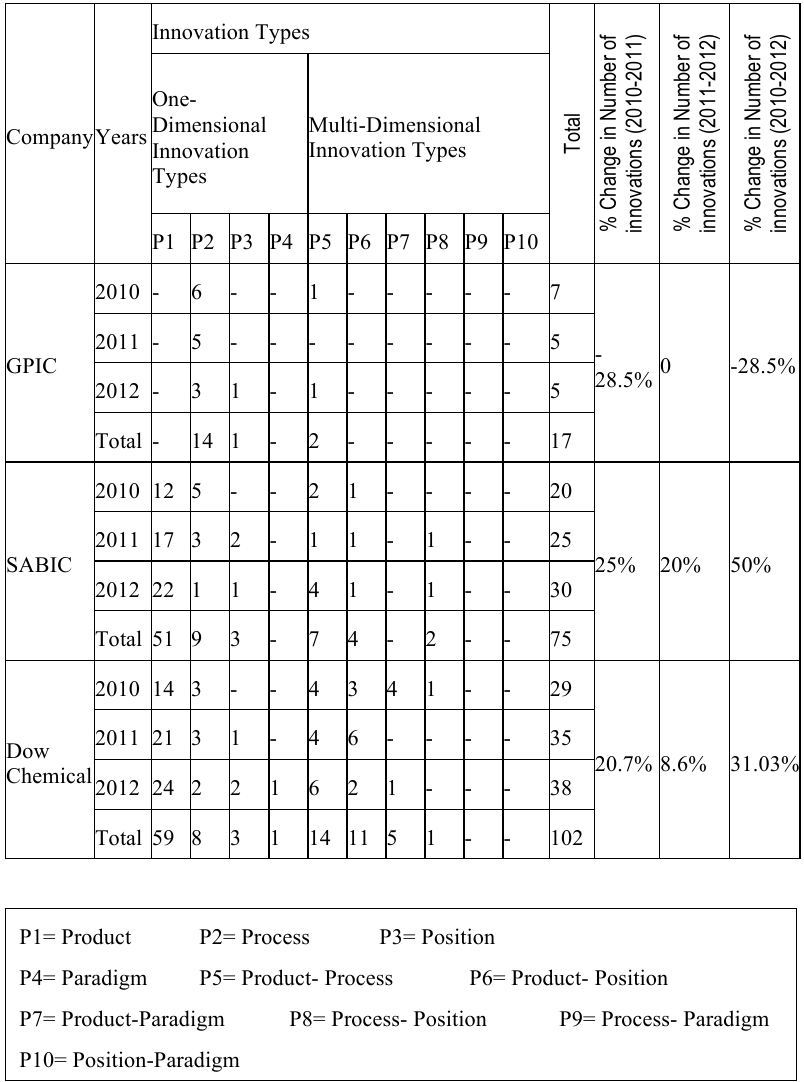
Table 1. Innovation number, Types, and Percentage of change in innovations number for the three companies (2010-2012)